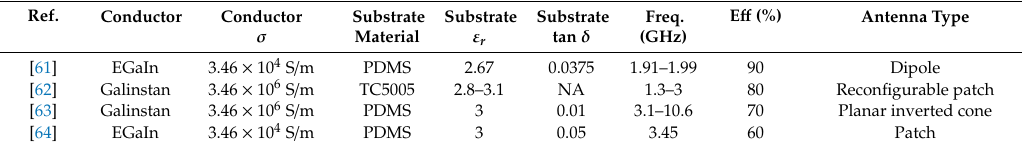
Table 4. Examples for antennas based on injection